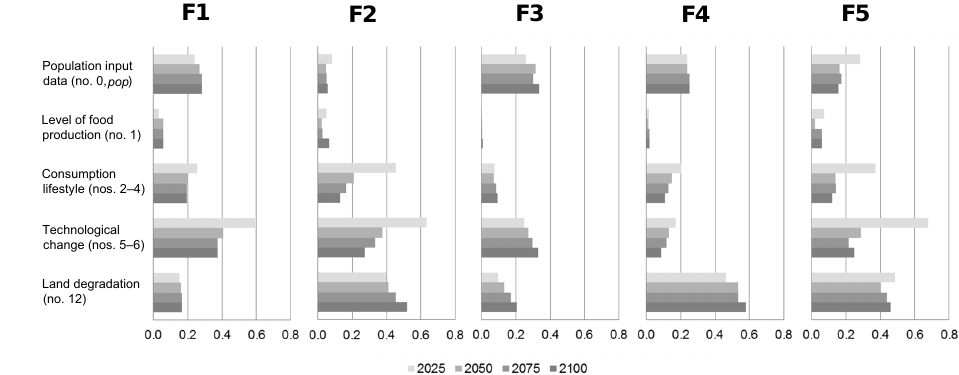
Figure 5. Total importance of global cropland for the futures F1–F5 to uncertainty of input parameters, aggregated to input parameter groups as in Table 2 (for non-aggregated results, see Fig. C1 in Appendix